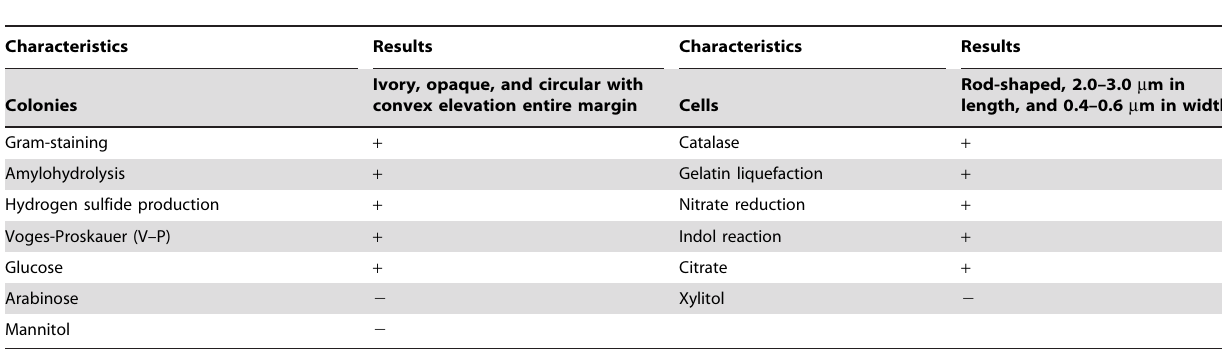
Table 2. Morphological and physio-biochemical characteristics of Bacillus sp. strain DG-02.